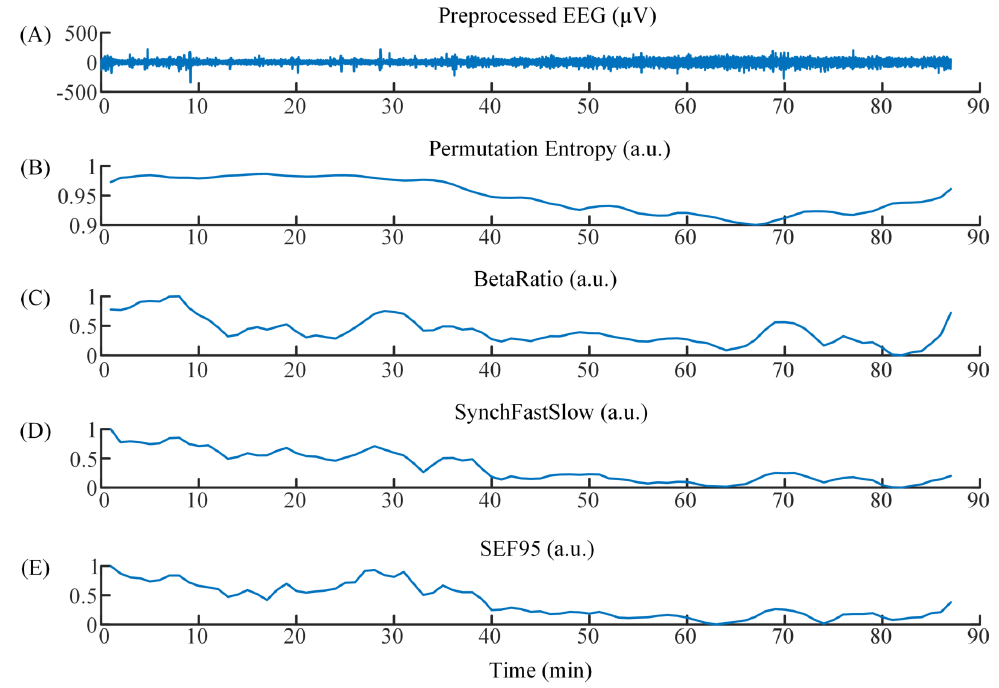
Figure 2. ( A ) The time course of preprocessed EEG. ( B )–( E ) The time courses of Permutation Entropy, BetaRatio, SynchFastSlow, and